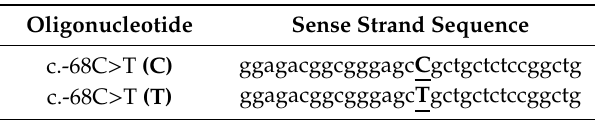
Table 5. Oligonucleotide sequences used in